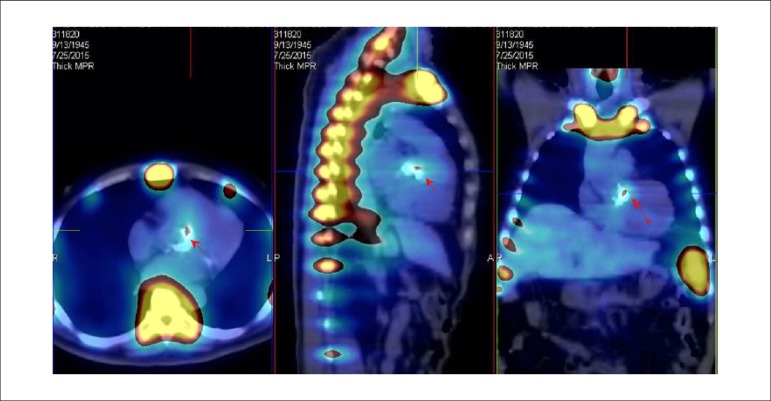
Images from scintigraphy with labeledleukocytes with SPECT/CT demonstrate anomalous accumulation in the area of the percutaneously implanted aortic valve (arrows). Transesophageal echocardiogram was inconclusive, and blood culture was positive for Staphylococcus aureus. The patient was diagnosed with prosthetic valve infective endocarditis.